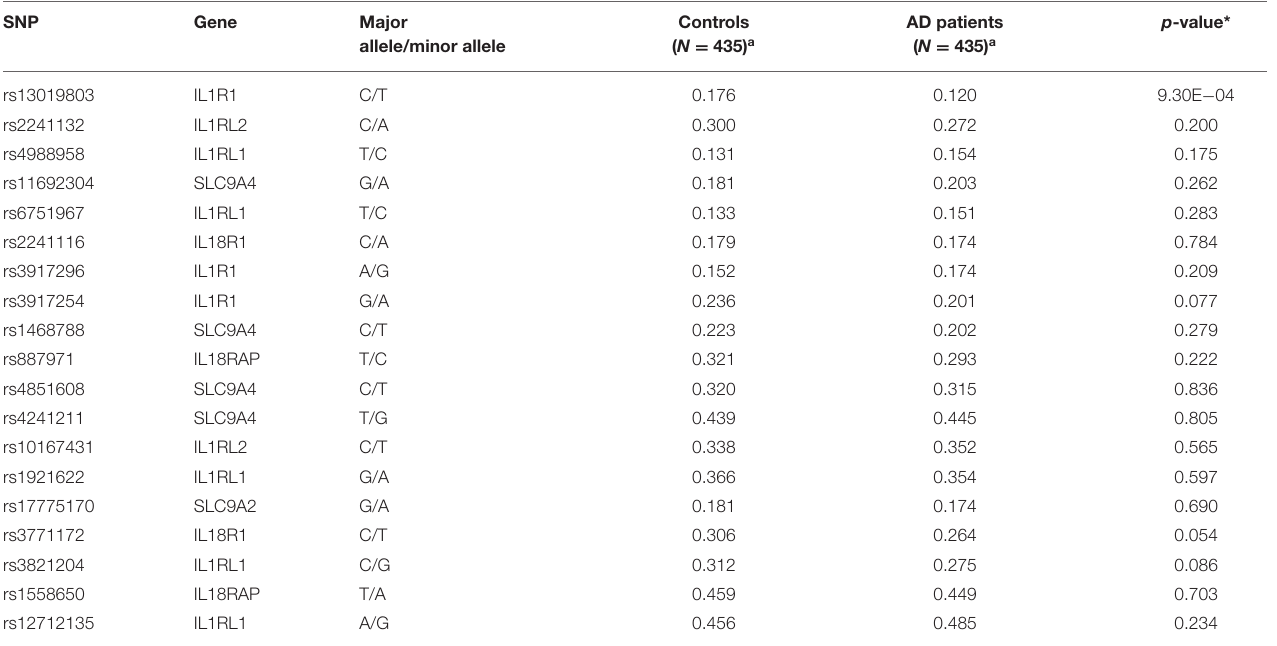
TABLE 2 | Genotype distribution and chi-square analysis in the discovery